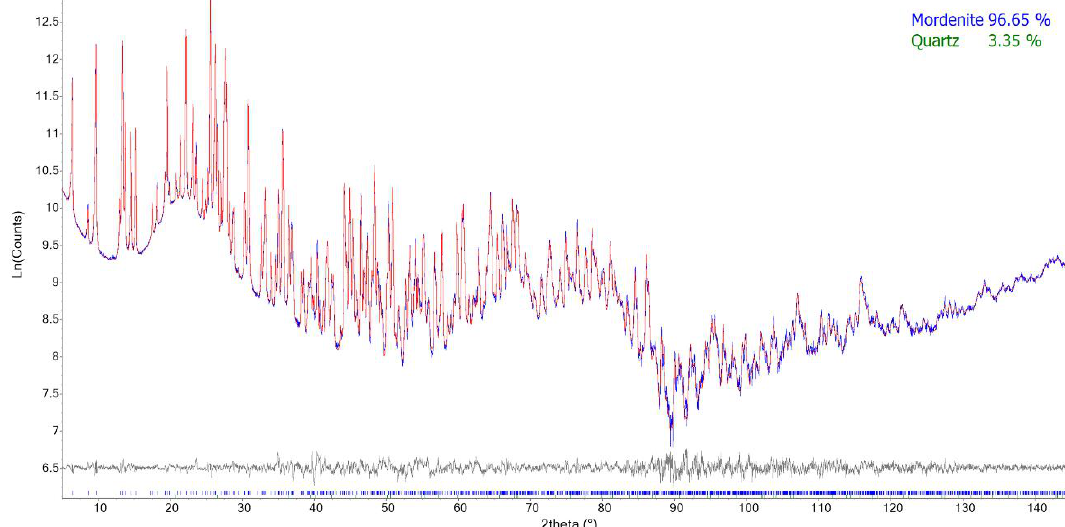
Figure 2. Conventional Rietveld plots of sample SP1. Intensity reported in logarithmic (natural) scale. Blue continuous line: experimental; red continuous line: calculated; grey continuous line: difference; below: vertical ticks color codes of Bragg reflections: blue mordenite; green quartz. Table 6. Miscellaneous data of the refinements. Statistic indicators as defined in Young [84]. Data of Mortier et al. [81] are reported for comparison (M76).